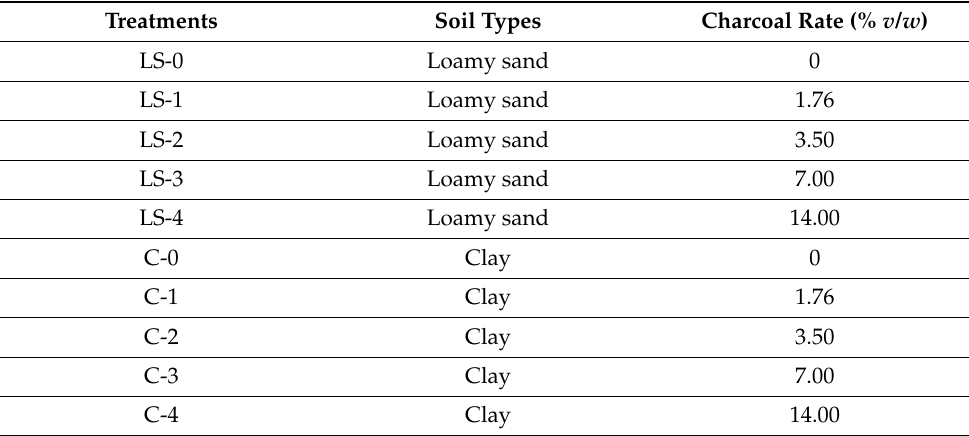
Table 3. Experimental design and